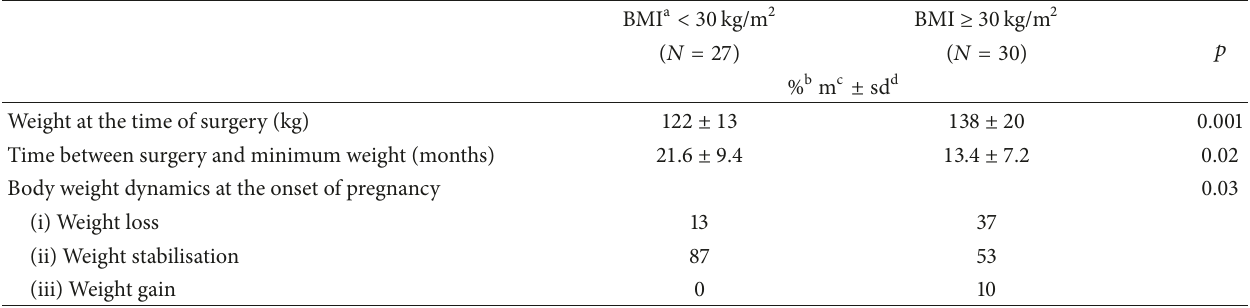
Table 7: Maternal and pregnancy-related characteristics according to Body Mass Index at the onset of pregnancy.